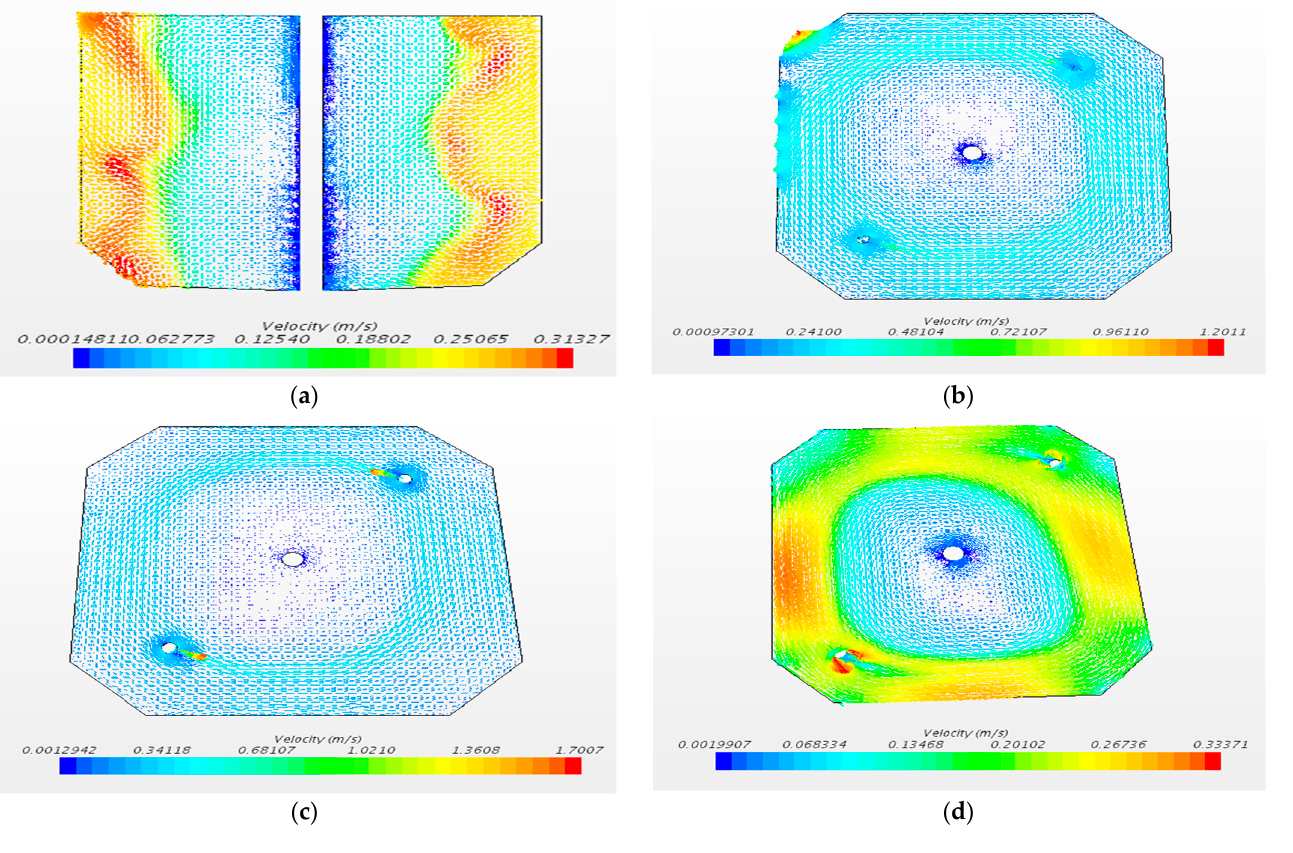
Figure 17. ( a ) middle longitudinal section, ( b ) H = 16.5 m cross section, ( c ) H = 8.5 m cross section, ( d ) H = 1.5 m cross section.